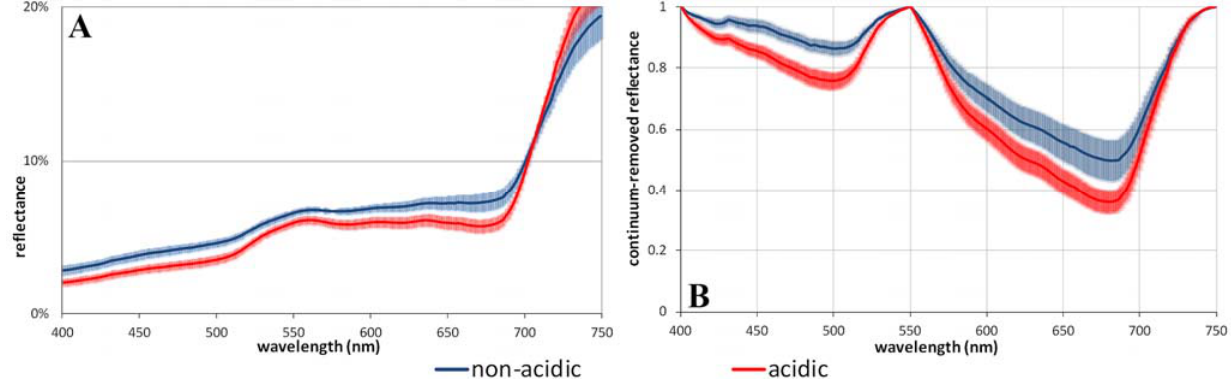
Figure 9. Spectral characteristics of the plant communities on acidic and non-acidic soils (soil pH zones). Comparison of ( A ) the averaged reflectance spectra in the visible (400–700 nm), and ( B ) the continuum-removed absorption features in the blue (400–550 nm) and red (550–750 nm) wavelength